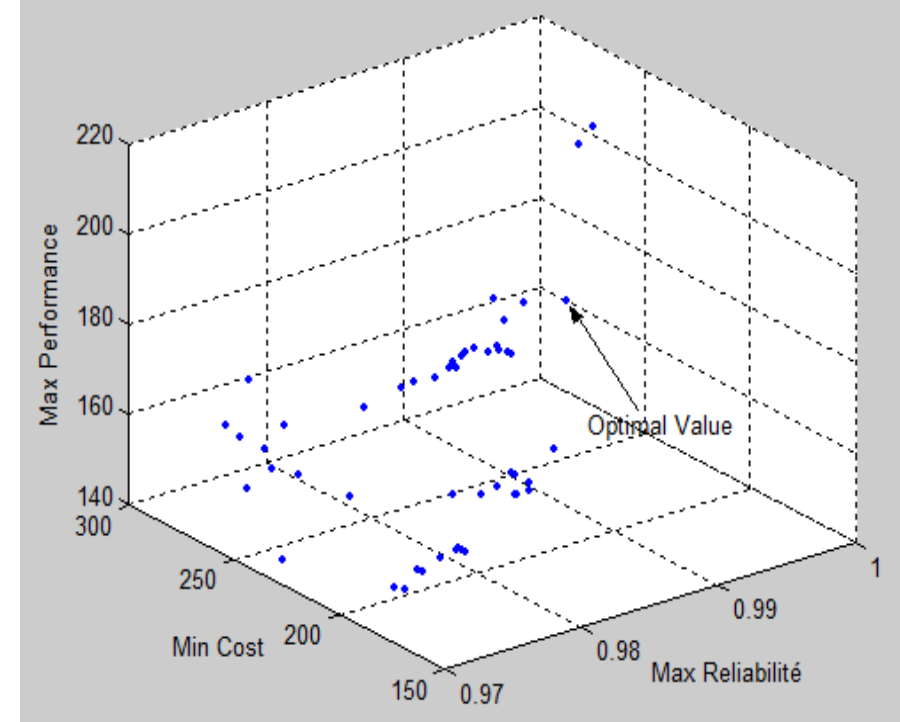
Figure 5. Pareto front of Example 1, multi-objective option.